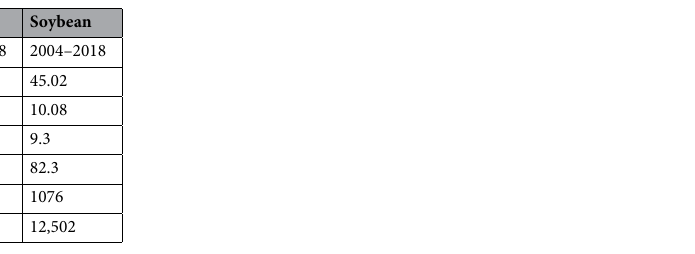
Table 2. The summary statistics of yield data across all years. The unit of yield is bushels per acre.